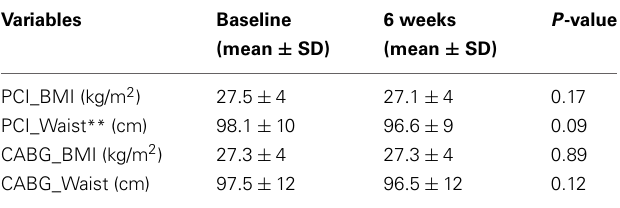
Table 2 | BMI and waist circumference in the CABG and PCI groups.